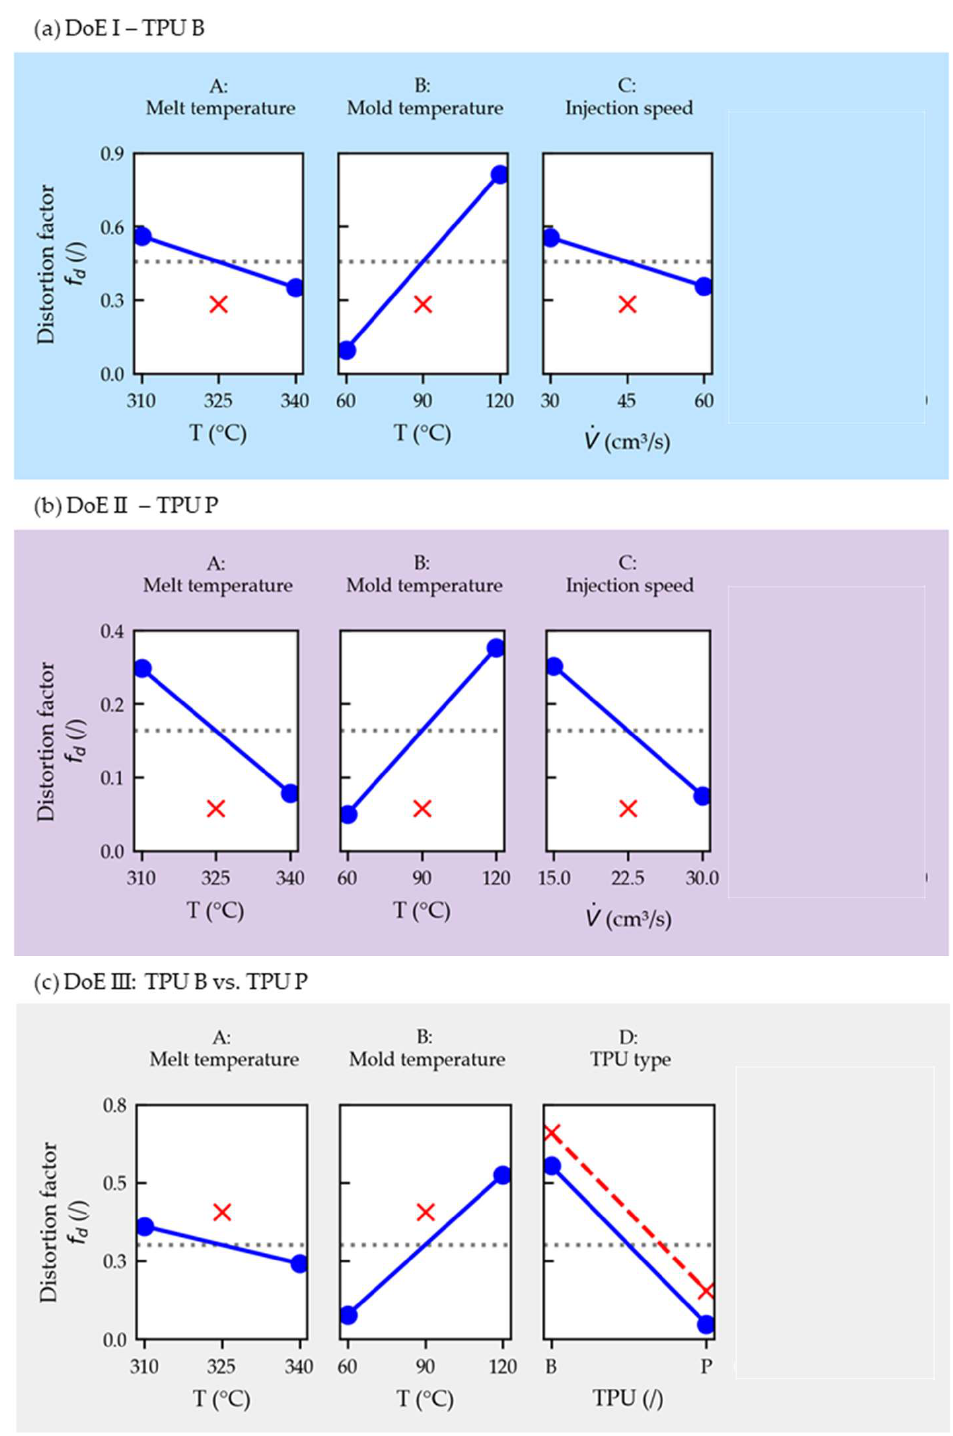
Figure 6. Main effects plots (including center points in red) for the distortion factors ( f d ) for DoE I ( a ), II ( b ) and III ( c ). The factor designations (A, B, C and D) relate to Table 4.